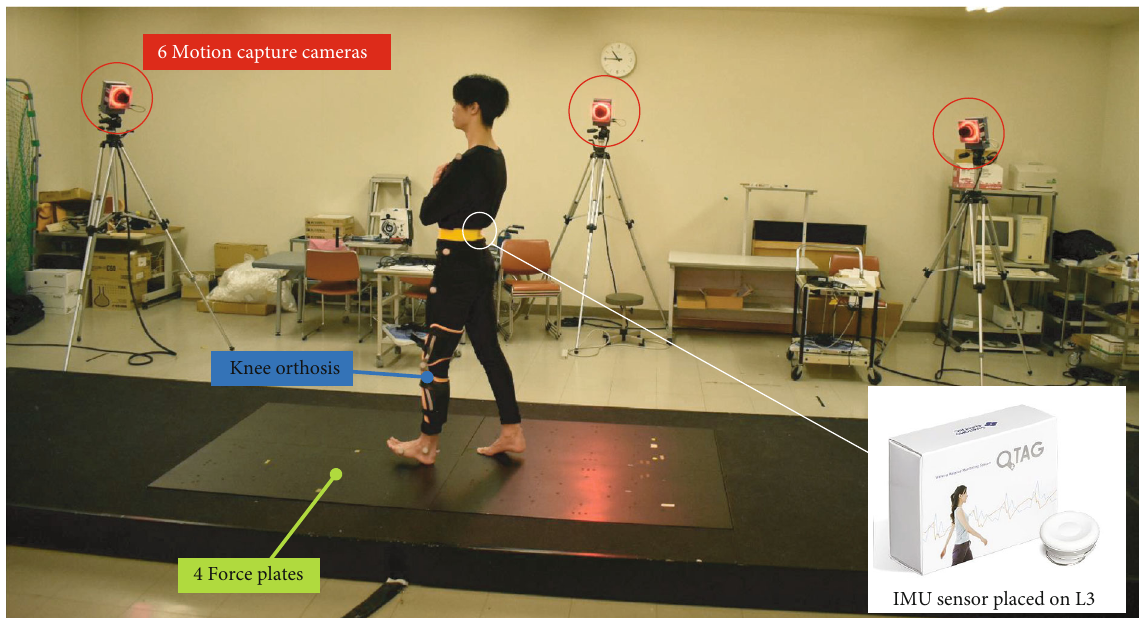
Figure 2: Illustration of synchronized sensor and motion analysis system. IMU: inertial measurement unit.